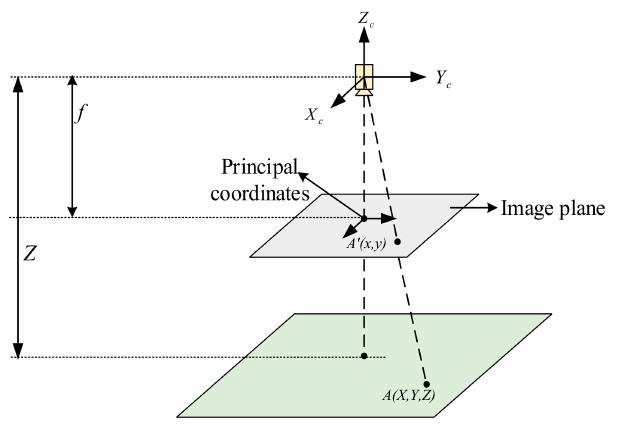
Figure 3. Schematic diagram of the correspondence between the target feature point and camera image plane. Z is the distance from camera to image, f is the camera focal length, A = ( X , Y , Z ) is spatial coordinates of image point, A (cid:48) = ( x , y ) is the projection of A = ( X , Y , Z ) in image